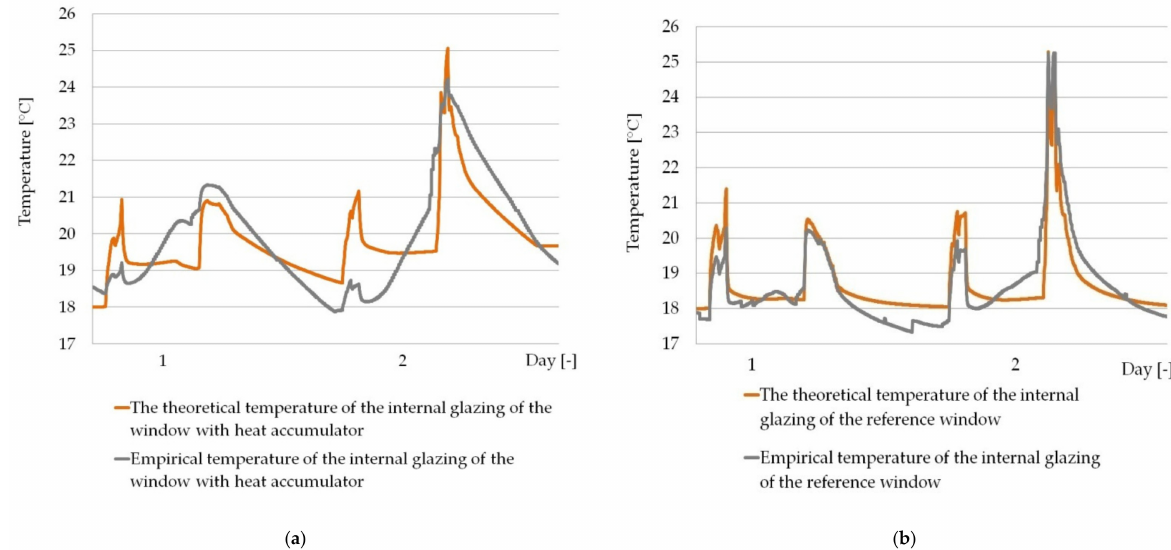
Figure 10. ( a ) Graphs of the measured and modelled temperature of the internal glazing surface of the window with the PCM heat accumulator; ( b ) Graphs of the measured and modelled temperature of the internal glazing surface of the reference